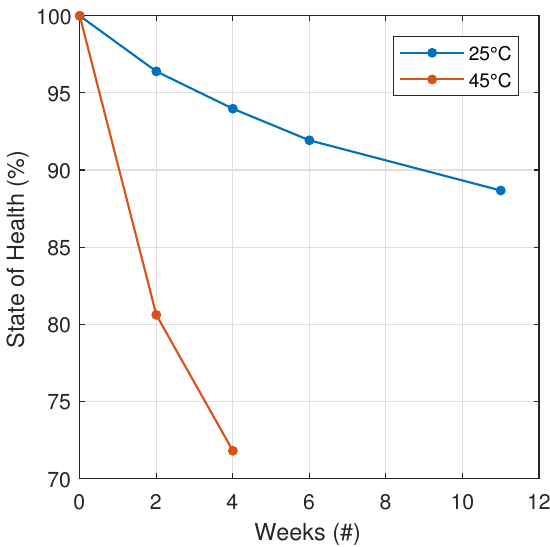
Figure 10. Discharge capacity of two calendar aged Si-alloy cells at 25 ◦ C and 45 ◦ C, stored at 4.4 V (100% SoC) and both stored at an optimized initial pressure of 7.5